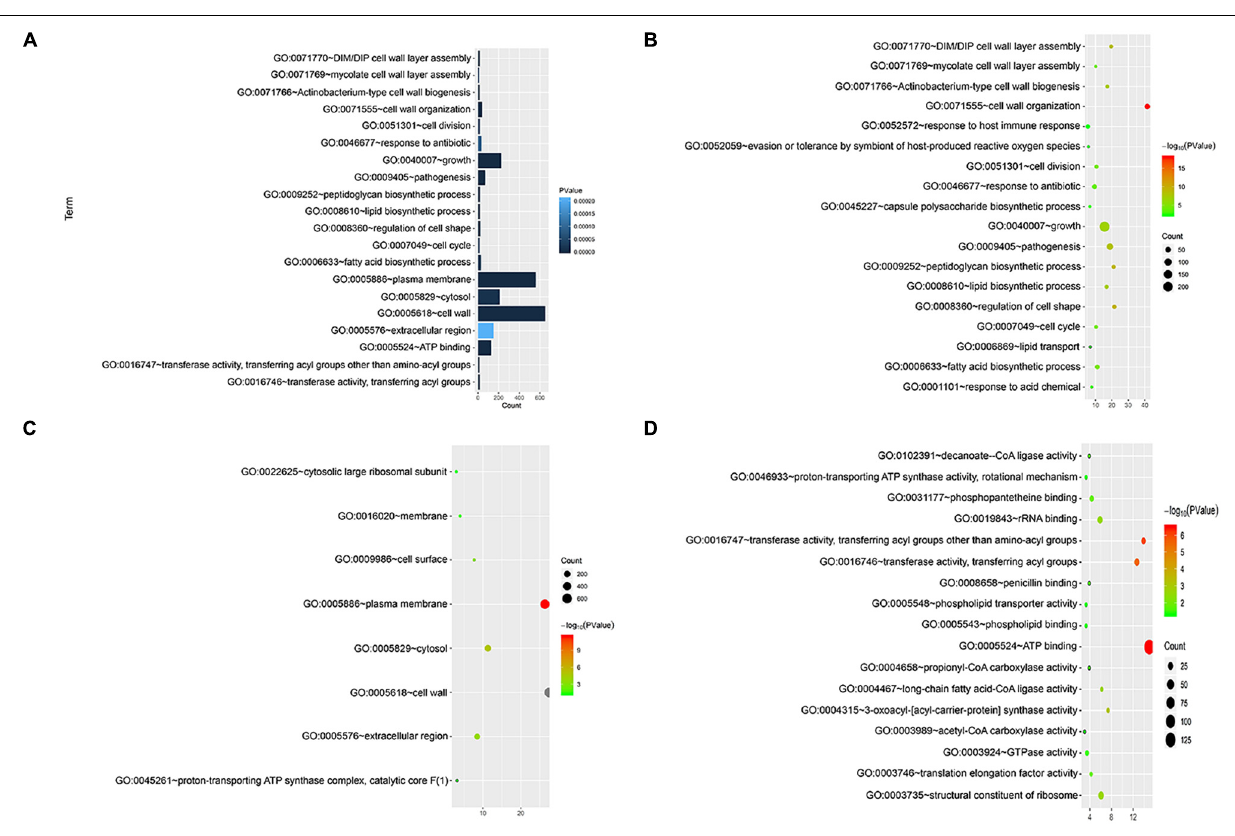
Frontiers in Bioengineering and Biotechnology | www.frontiersin.org